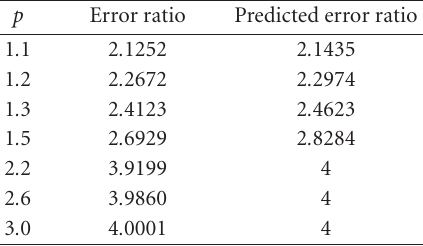
(cid:21) Table 3.5. Approximation of 1 on W k ,1 -surfaces, precision 2 quadrature. p Error ratio